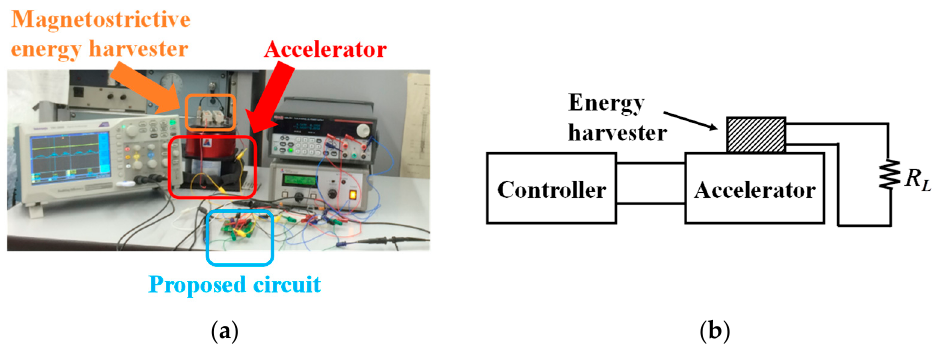
Figure 18. Measurement set-up: photograph ( a ) and block diagram ( b ).